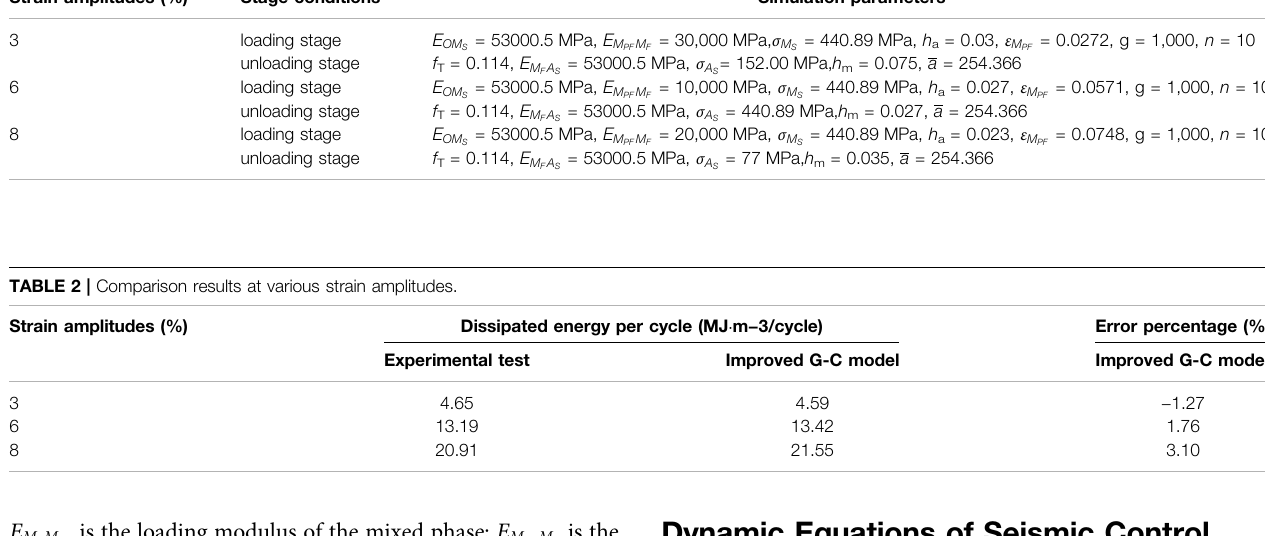
TABLE 1 | Simulation parameters of SMA wires. Strain amplitudes (%)